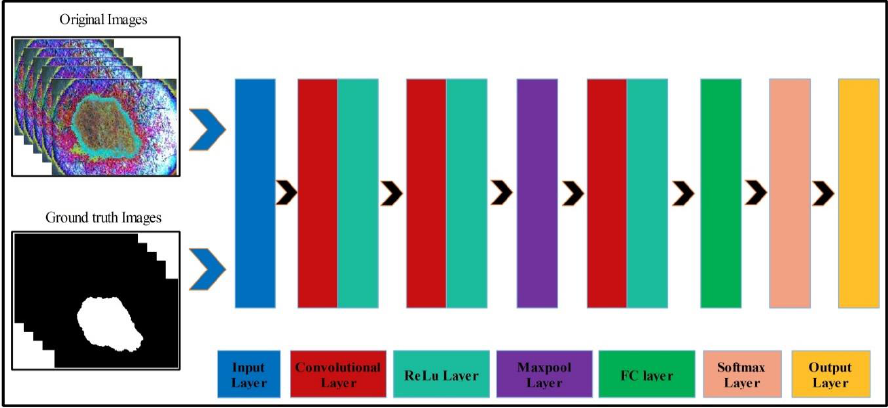
Figure 7. Designed CNN model for skin lesion visualization.